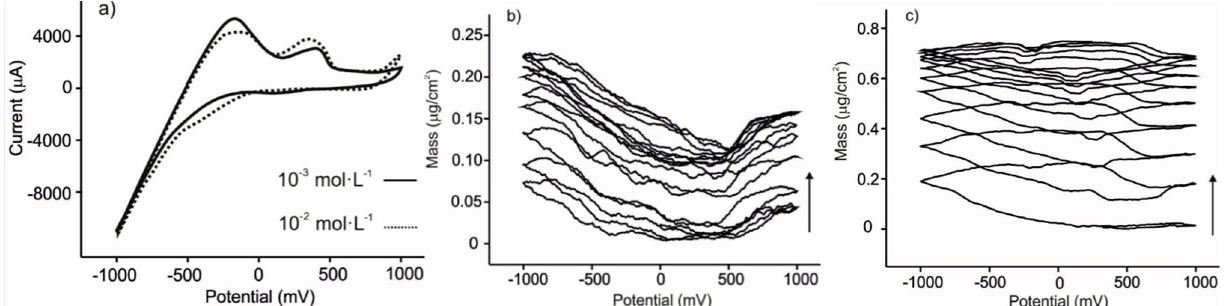
Figure 3. ( a ) Voltammetric response towards catechol in KCl 0.1 mol·L − 1 for the CuPc SO3 /PAH sensor; ( b ) Mass response of the CuPc SO3 /PAH sensor towards glucose 10 − 3 mol·L − 1 in 0.01 mol·L − 1 phosphate buffer (pH 7.0); ( c ) Mass response of the CuPc SO3 /PAH sensor towards glucose 10 − 2 mol·L − 1 in 0.01 mol·L − 1 phosphate buffer (pH